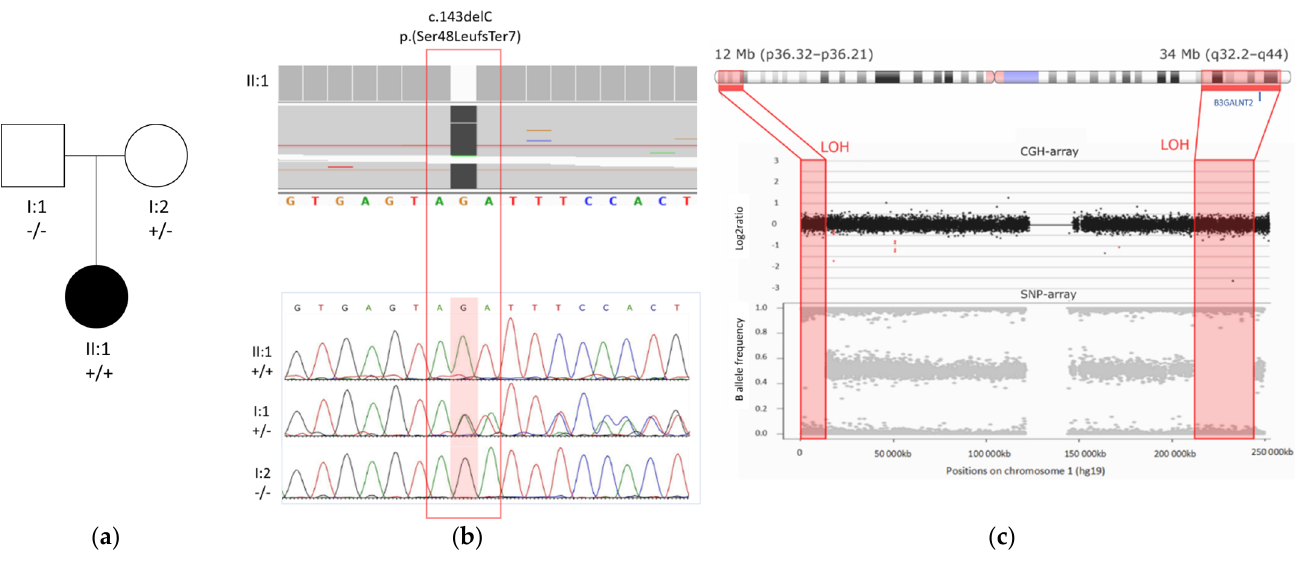
Figure 3. B3GALNT2 variant and mixed UPD found by WES. ( a ) Pedigree of the family of the patient described in this case report; the mutant allele is represented with a ‘+’ sign and the wild type allele with a ‘–’ sign. ( b ) Top: exome sequencing reads of the proband (II:1) showing the